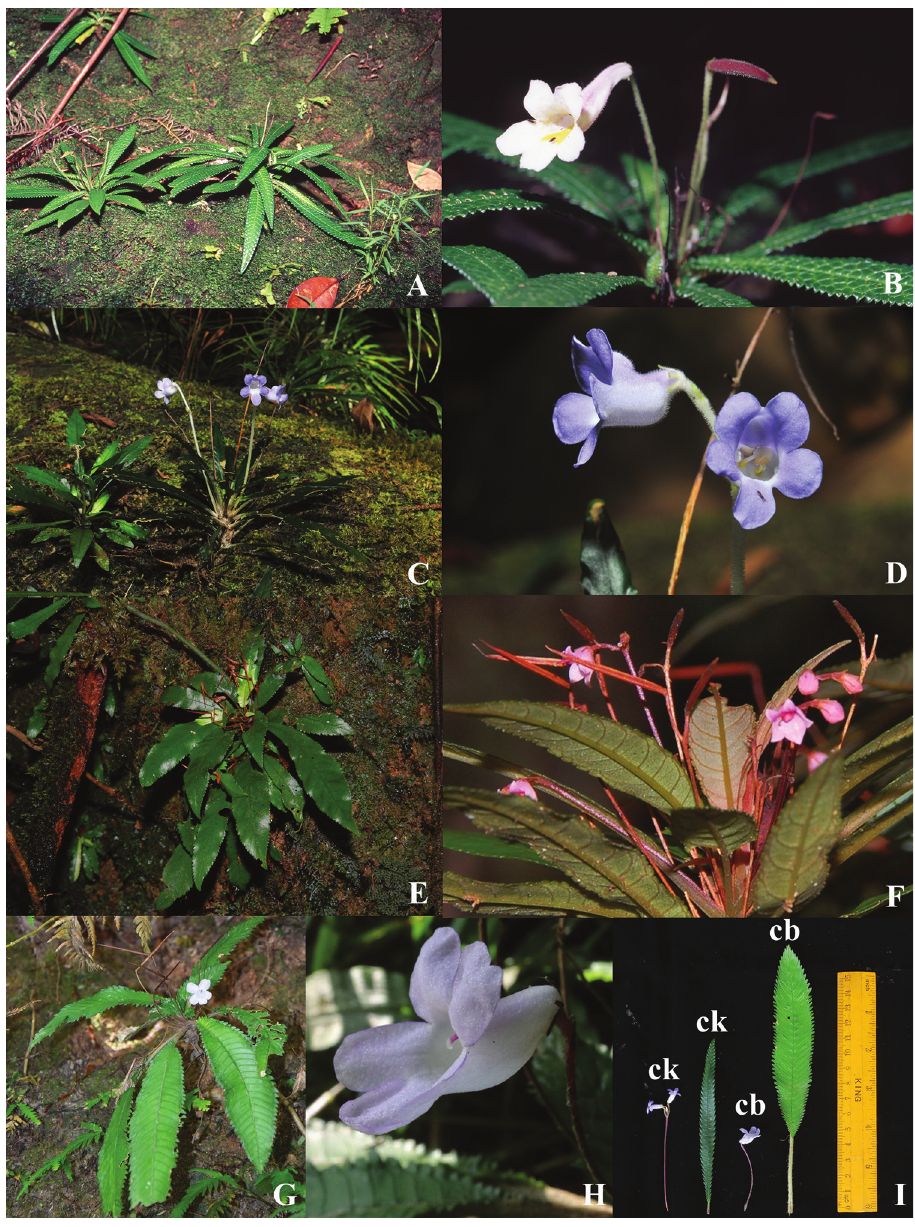
Figure 3. A, B Codonoboea rheophytica C, D Codonoboea densifolia e, F Codonoboea salicina G, h Codonoboea breviflora I ck = Codonoboea kenaboiensis , cb = Codonoboea breviflora